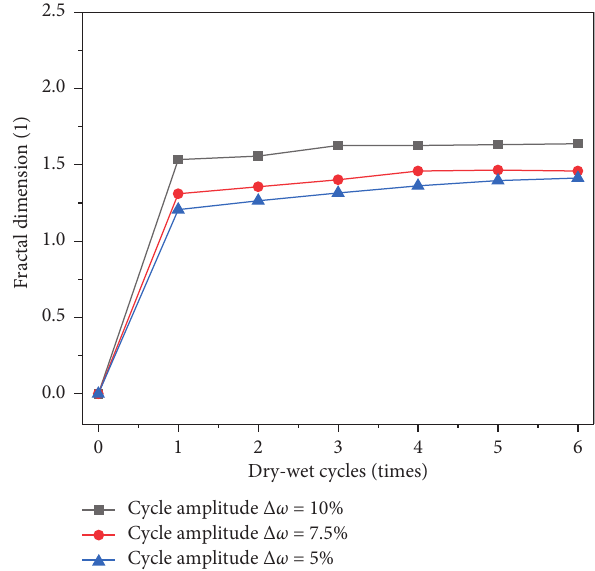
Figure 5: Curves of the fractal dimension of the fissures on the surface of the loess samples, number of cycles, and